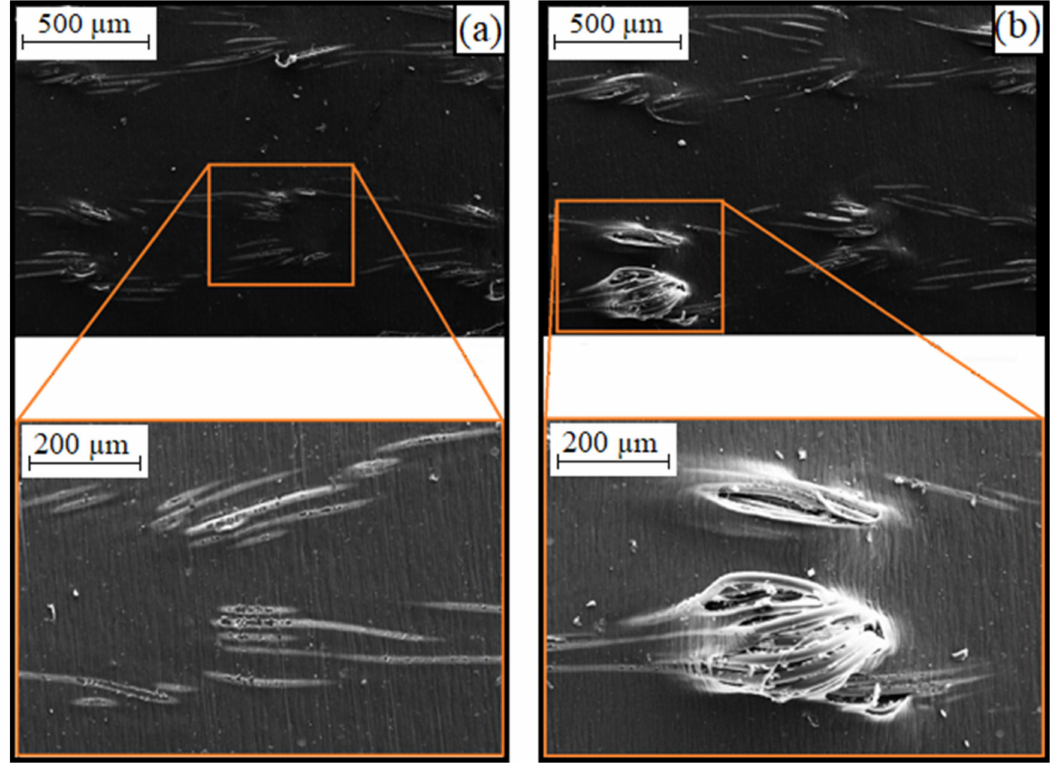
Figure 13. SEM images of samples with conductors made of knitted textiles: ( a ) untested; ( b ) loaded (300,000 cycles at a strain amplitude of